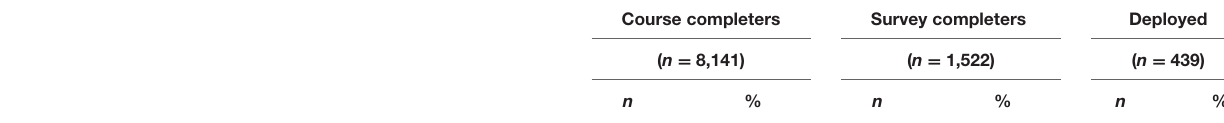
TABLE 1 | Demographic characteristics of course participants and study sample.